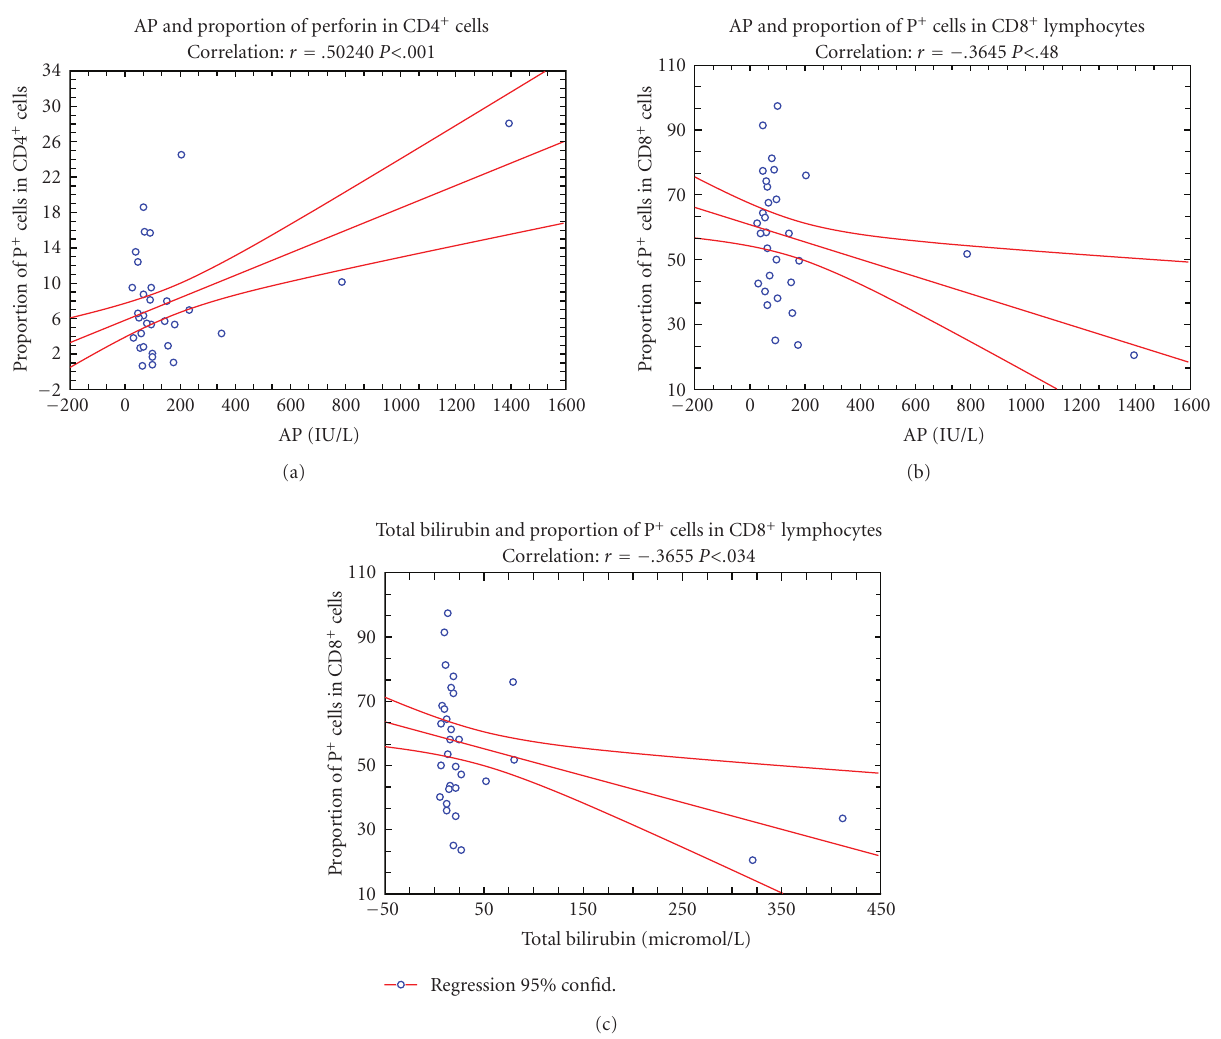
Figure 8: Correlation ( r ) between preoperative serum levels of alkaline phosphatase (AP) and total bilirubin and the proportion of CD4 + P + cells or fraction of perforin positive (P+) cells inside the CD8 + subpopulation of T cells,